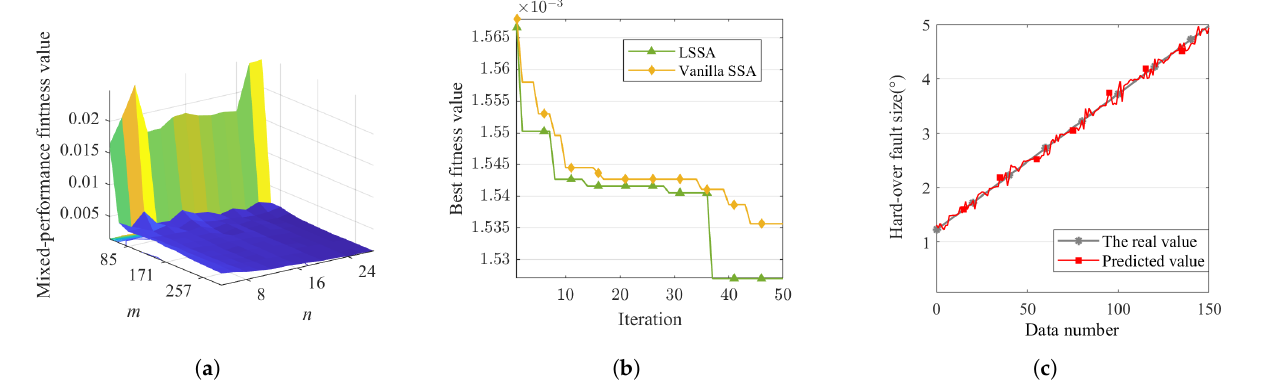
Figure 8. The offline training results of hard-over fault. ( a ) Parameter and objective space of the RF structure parameter optimization. ( b ) Fitness curves of the LSSA and the Vanilla SSA. ( c ) Prediction of the trained RF identifier. The test data used for ( c ) are obtained by injecting the hard-over fault with different size into the QUAV system 160 times, where fault size is between 1 to 5 with an interval of